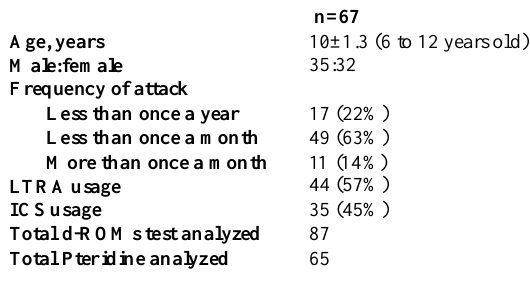
Table 1.: Clinical characteristics of study